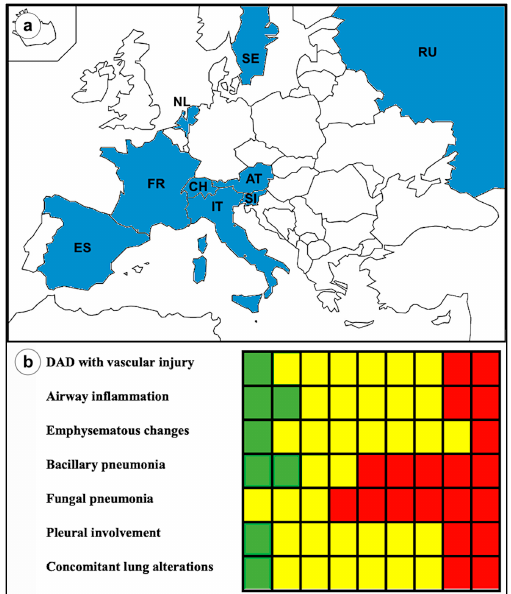
Figure 1. The European countries participating in the survey were Austria (AT), France (FR), Italy (IT), the Netherlands (NL), Russia (RU); Slovenia (SI), Spain (ES), Switzerland (CH), and Sweden (SE) ( a ). The frequency of pathological COVID-19-associated lung lesions during the two pandemic waves ( b ). Each box represents the answer of each participant. Green: more frequent during the first wave. Red: more frequent during the second wave. Yellow: equally present during both waves.